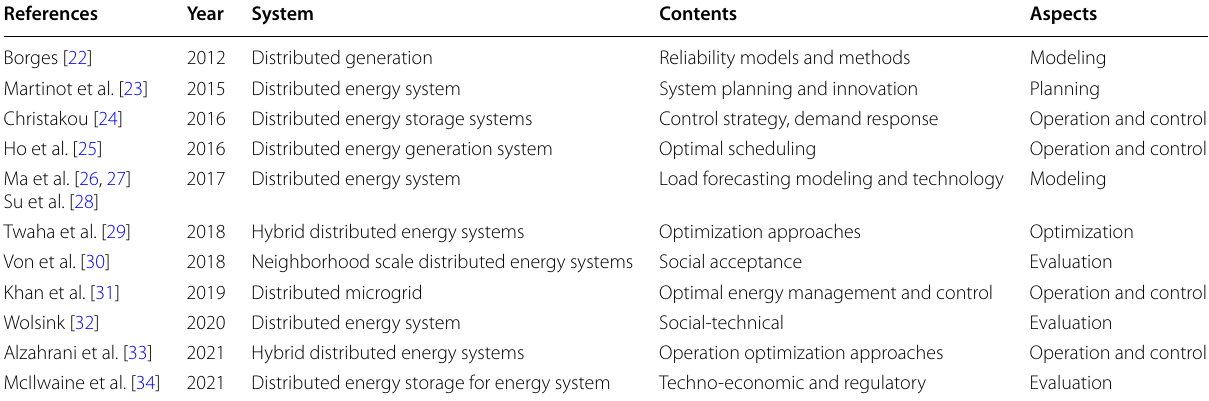
Table 1 Some review publications about distributed energy systems in the last